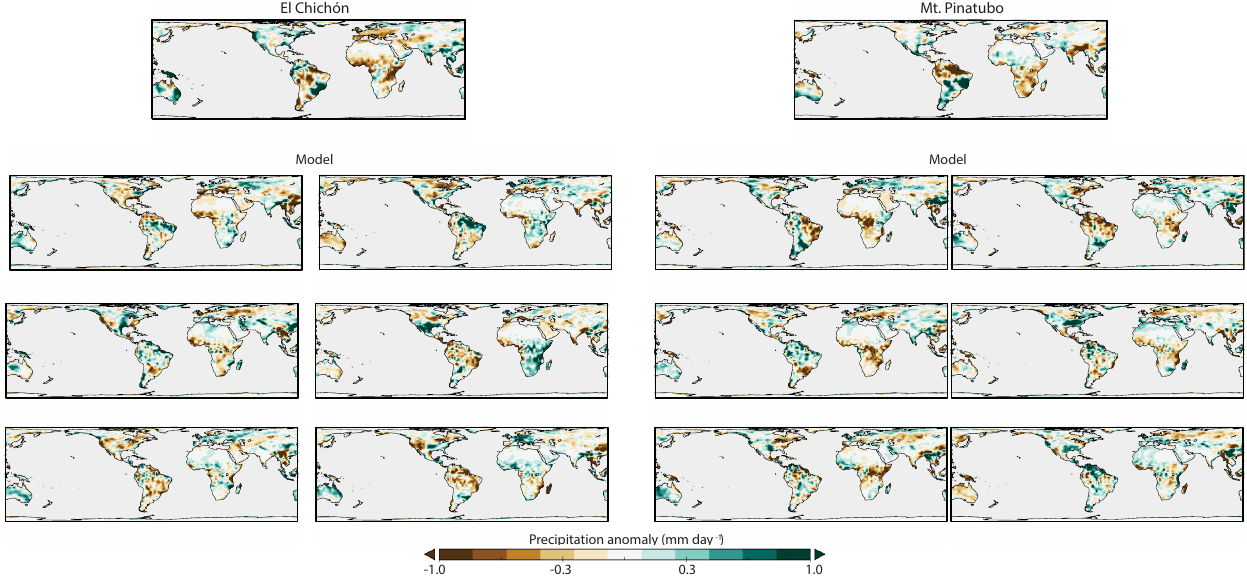
Figure 6. As in Fig. 5, except for precipitation change (mmday − 1 ).